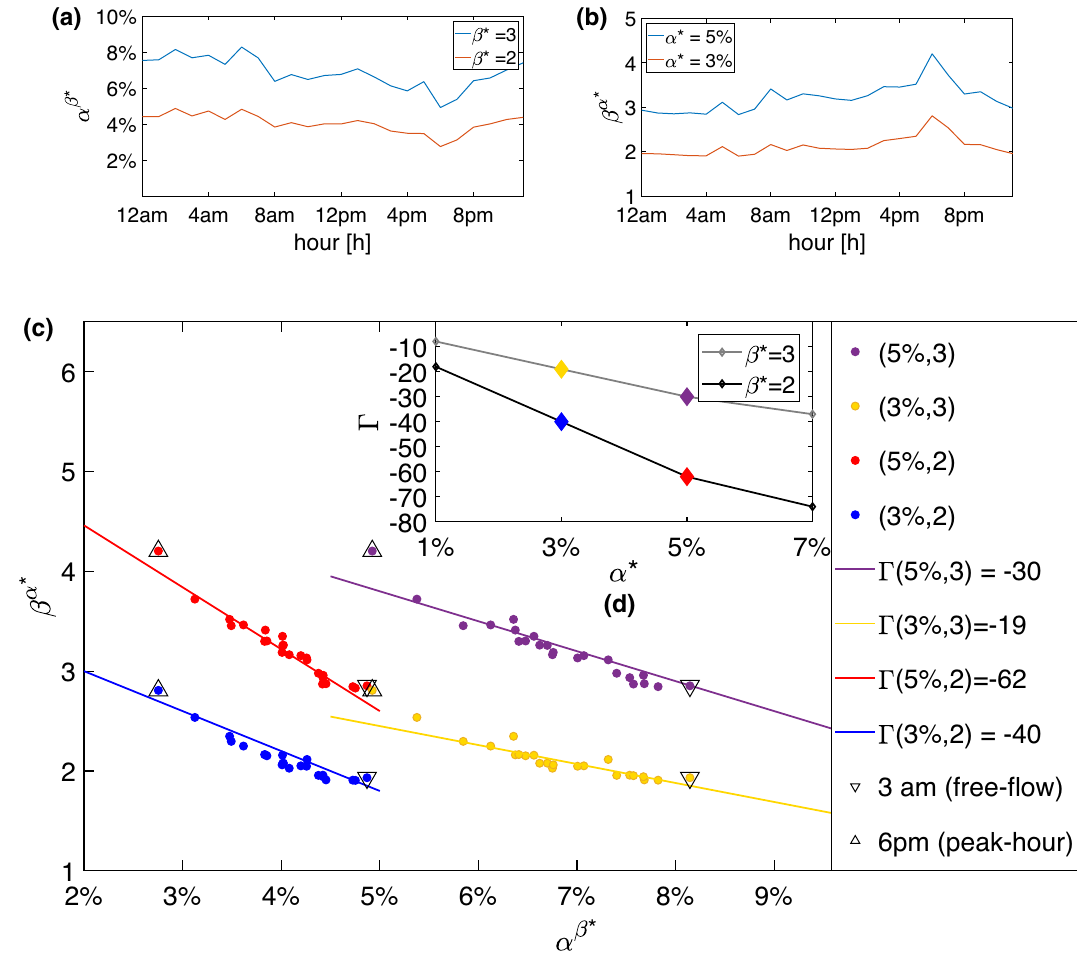
Figure 5. The α and β dilemma factors and their correlations. Daily variations of the network dilemma factors (averages are taken over all the station nodes of the network) for two fixed values of β ∗ ( a ) and two different values of α ∗ ( b ). Correlations between the two dilemma factors are studied by the scatter plot (α β reported in panel ( c ). Each point here represents a different hour of the day, from midnight to 11 p.m. (peak- hour 6 p.m. and free-flow regime 3 a.m. are shown with up- and down-pointing triangles respectively), while the color indicates a different pair of values α ∗ , β ∗ ) . The linear relation between the two factors is highlighted by a linear fitting in the four studied cases. ( d ) The Ŵ correlation coefficients obtained from the slope of the fitting in eight different cases corresponding to β ∗ = 2, 3 (grey and black) and four values of α ∗ = 1, 3, 5, 7% . The colors of the four central diamonds correspond to the four cases reported in ( c ). Ŵ quantifies the richness of the alternative paths that the transportation system offers to travellers if we allow paths with travel times α ∗ % longer than the shortest